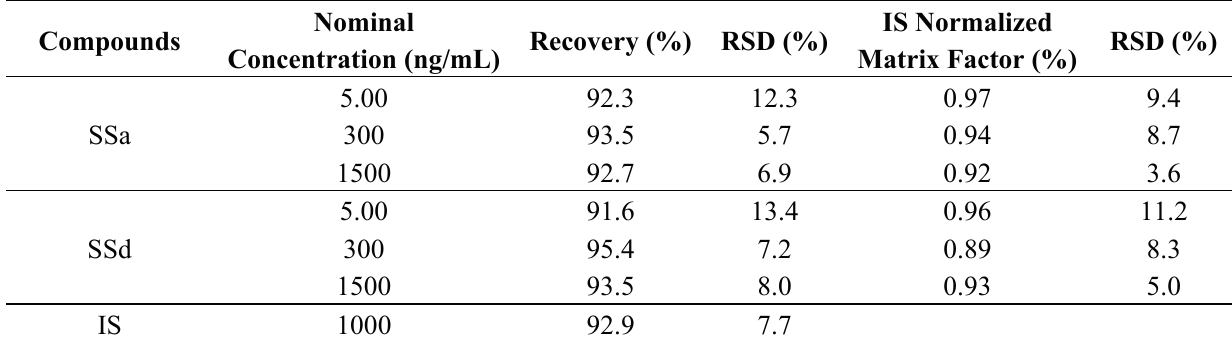
Table 9. Extraction recovery and internal standard (IS) normalized matrix effect factor